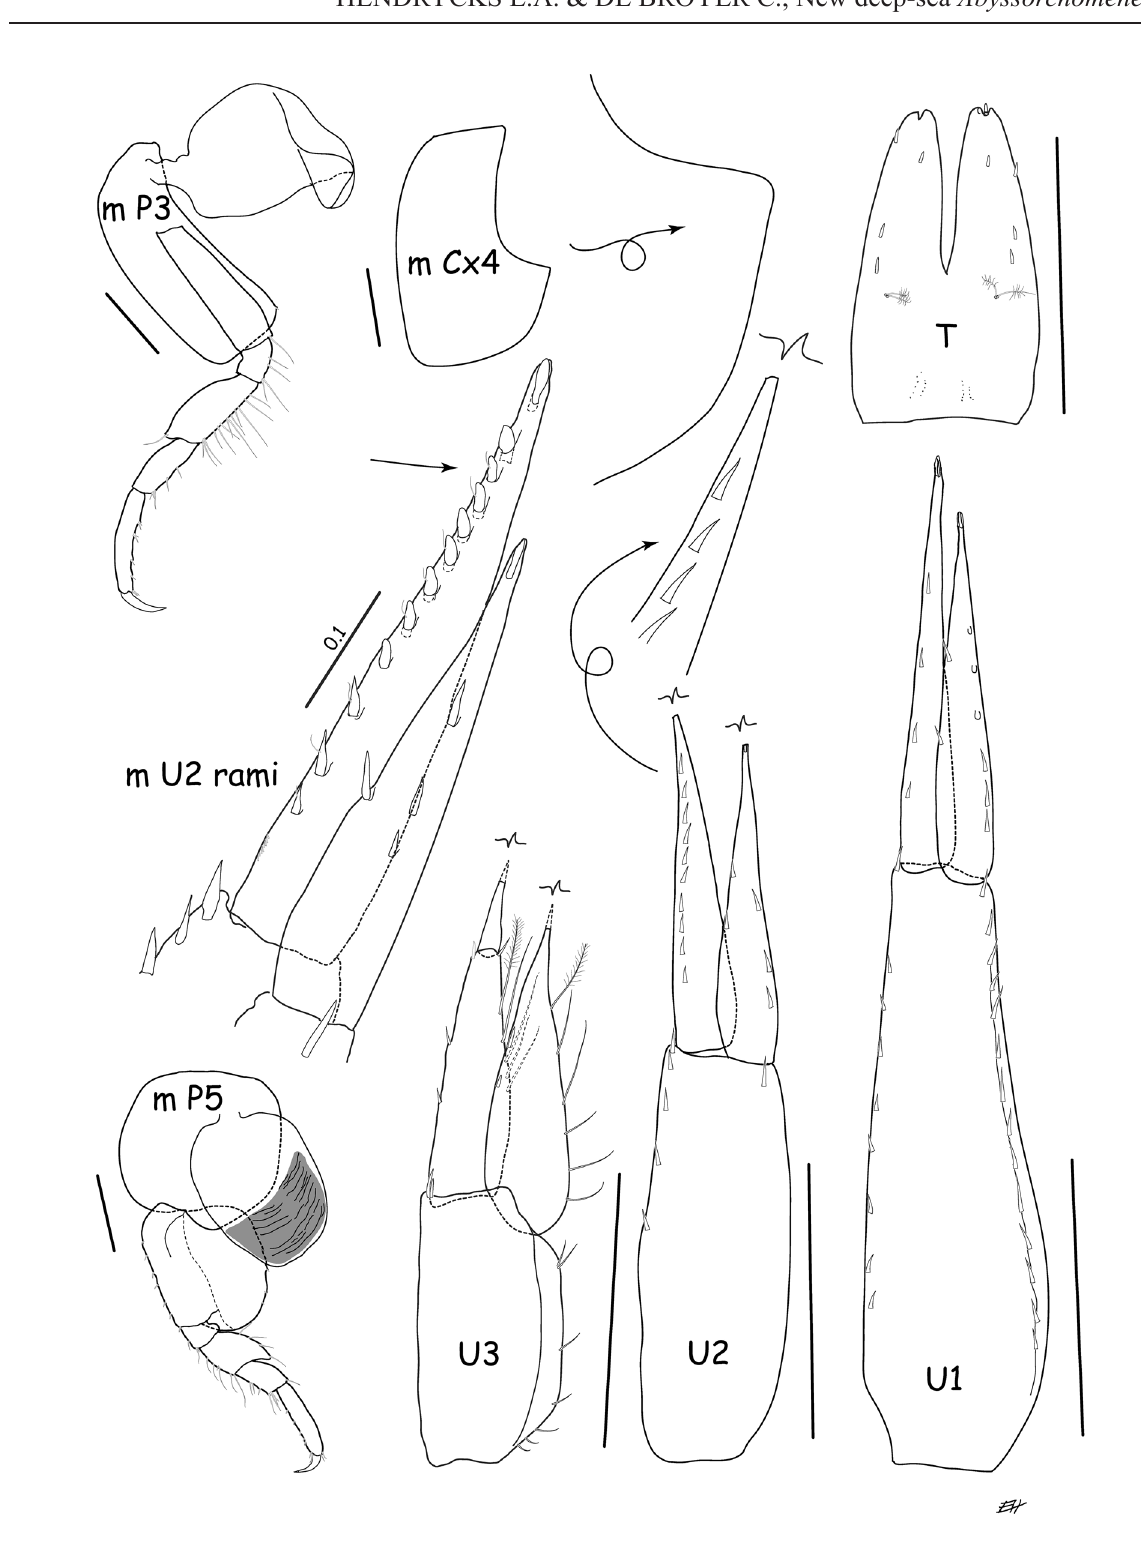
Fig. 17. Abyssorchomene patriciae sp. nov., holotype, ♀, 10.5 mm (NHM UK 2022.6); allotype, ♂, 7.5 mm (NHM UK 2022.7). Figures with sex not indicated are of female. Scale bars = 0.5 mm unless indicated